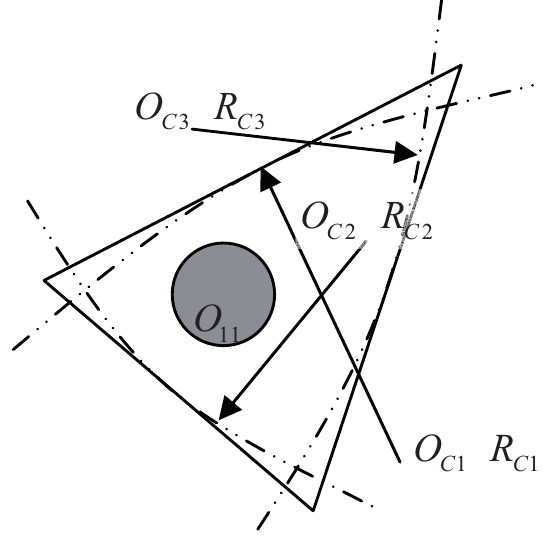
Fig. 5. Approximation of a convex design